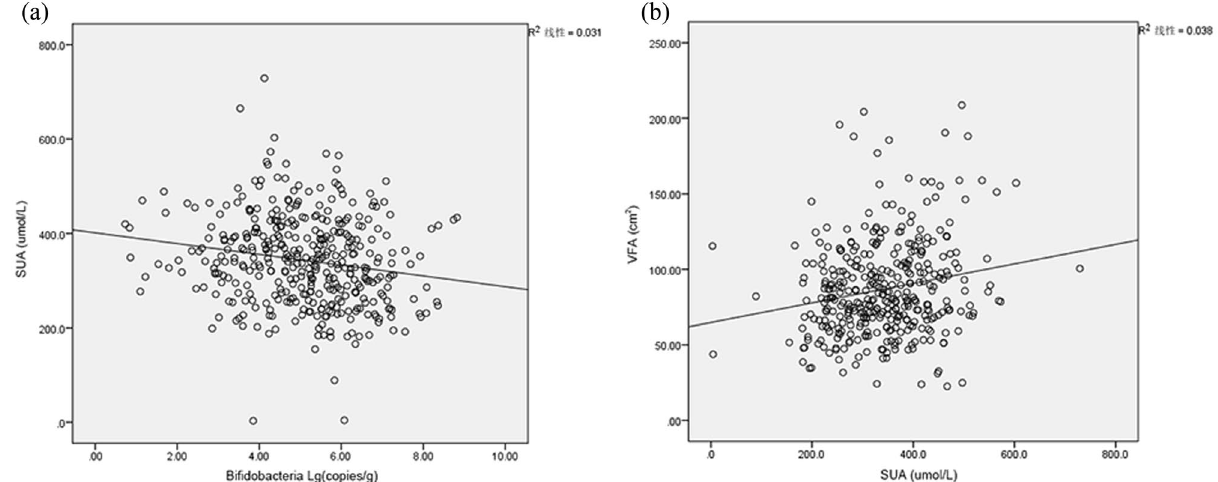
Figure 3. Bifidobacterium was negatively correlated with SUA ( a ) (R = − 0.176 P < 0.01). SUA was positively correlated with VFA ( b ) (R = 0.195, P = 0.000). SUA serum uric acid. VFA visceral fat area.